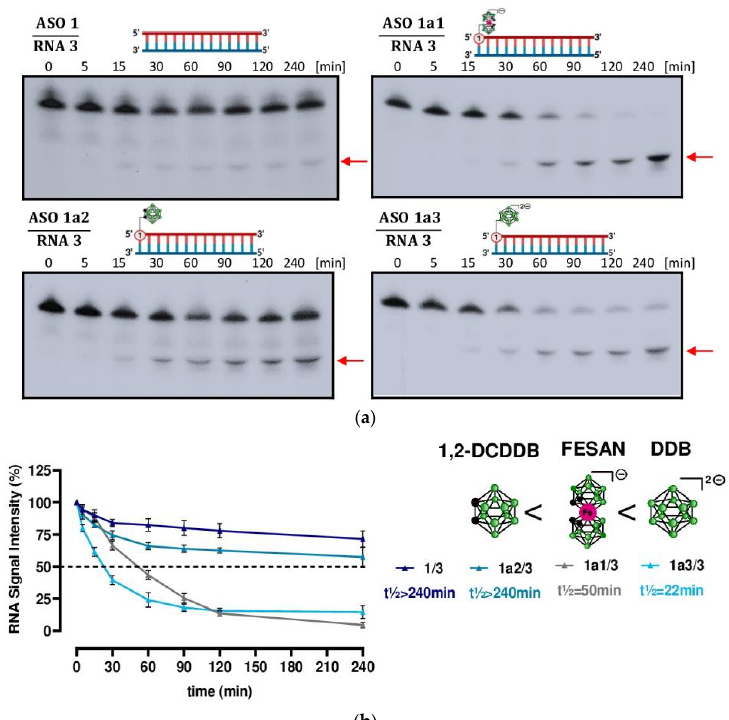
Figure 4. Autoradiograms of 20% denaturing PAGE, showing the cleavage of 5′ -[ 32 P]-labelled RNA 3 into duplexes containing ASO 1 or B-ASO- 1a ( 1a 1 , 1a 2 , 1a 3 ) decorated with one of the three types of boron clusters (FESAN), (1,2-DCDDB) or (DDB) units (panel a , b ) after treatment with RNase H (1 µL of 0.1 U/µL stock solution) at 0, 5, 15, 30, 60, 90, 120 and 240 min. Densitometric analyses of intact 5′ -[ 32 P]-RNA 3 substrate content were performed using three independent PAGE analysis experiments (panel b ). The red arrows indicate products of degraded 5′ -[ 32 P]-RNA 3 . Experimental conditions are described in the Materials and Methods section. Figure were created in BioRender (https://biorender.com/, accessed on 23 June 2022) and GraphPad Prism (https: //www.graphpad.com/, accessed on 15 August